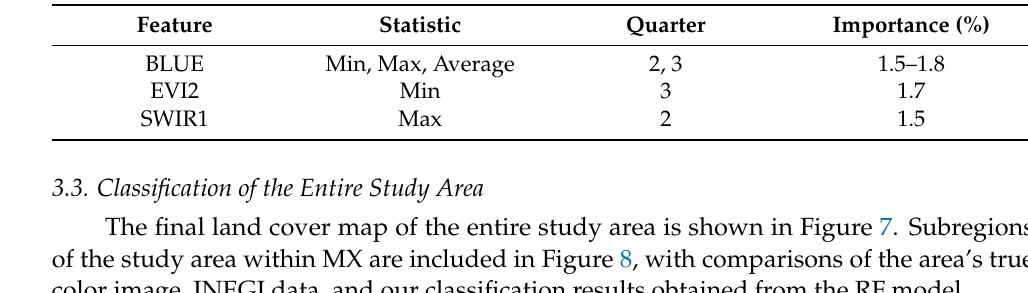
Table 5. Highest ranking features in terms of importance to the RF